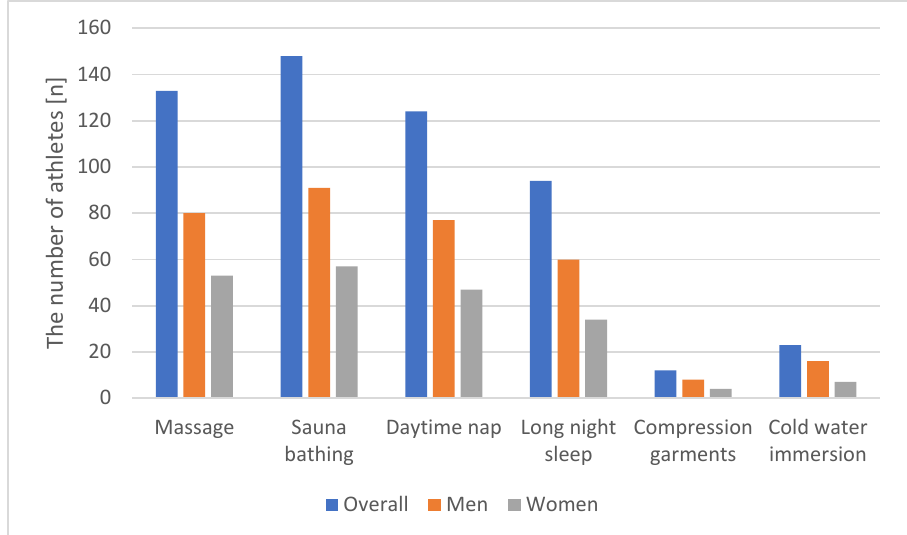
Figure 1. The use of recovery technique according to athletes’ gender.